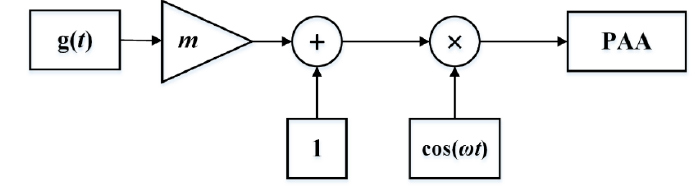
Figure 5. Block diagram of DSBAM.